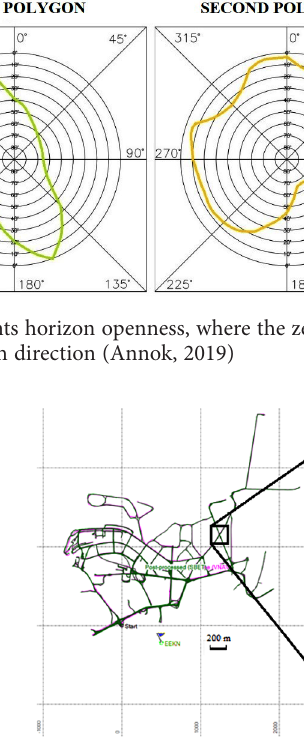
Figure 4. The trajectory computed with Kunda reference station (EEKN) and excerpt of the area where research polygons are located. Purple shows the primal trajectory and green the corrected trajectory (Annok,